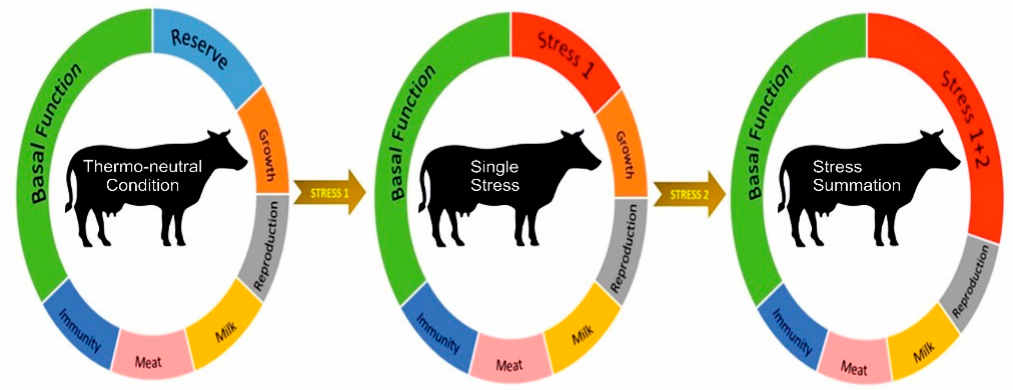
Figure 1. Schematic highlighting the concept of multiple stressors on cattle (adopted and modified from Sejian et al. [30] ).